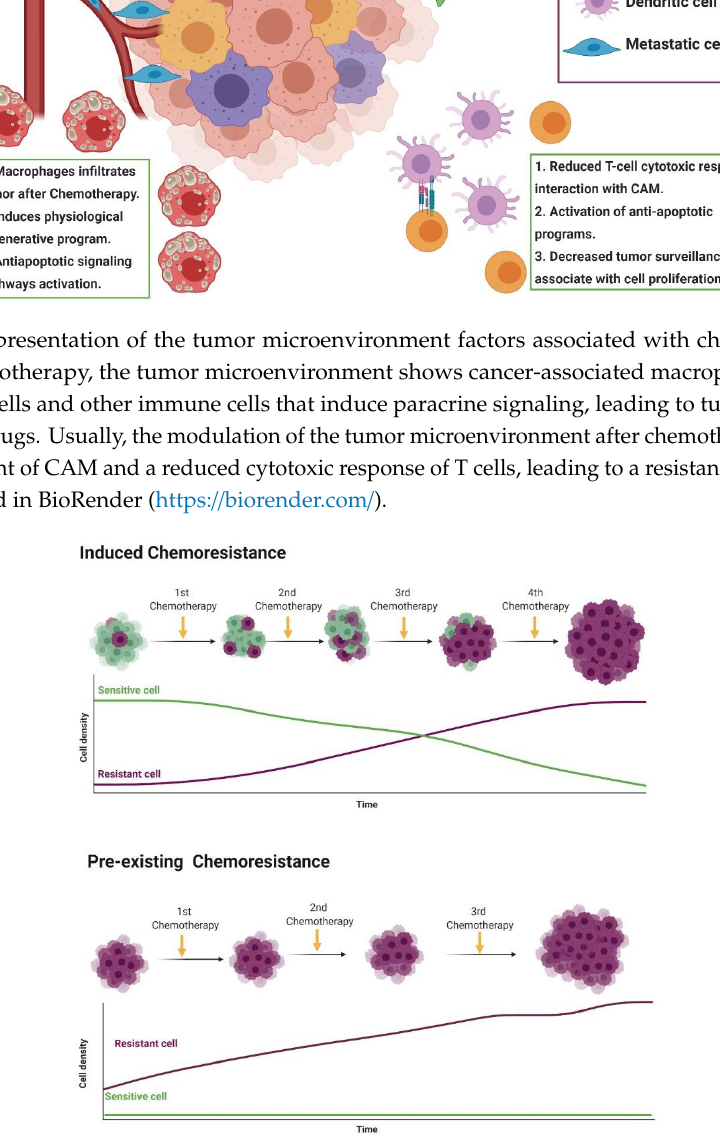
Figure 2. Representation of intrinsic chemoresistance in breast cancer (BC). Usually, tumor cells